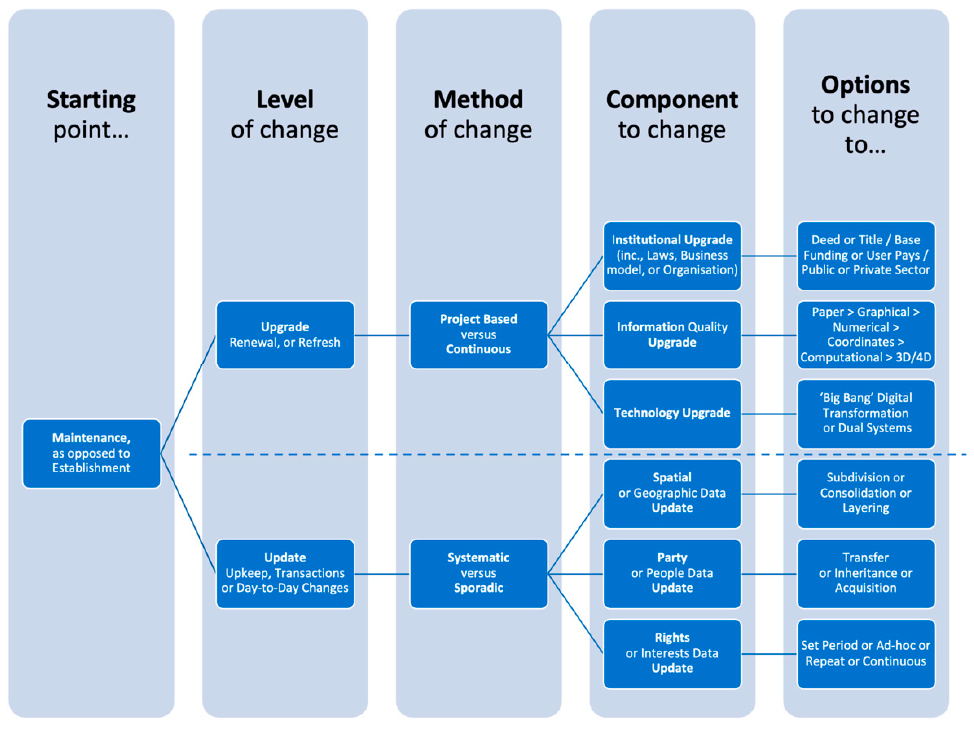
Figure 2. The overarching maintenance problem is an aggregation of many aspects and various ter ‐ minology (source: [4]). terminology (source: